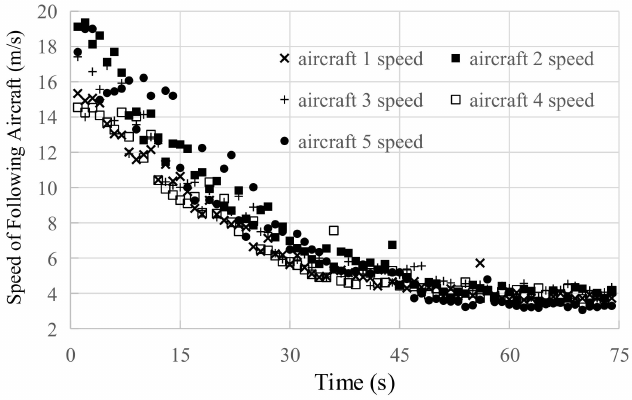
Figure 9. The Taxiing Speed of the Following